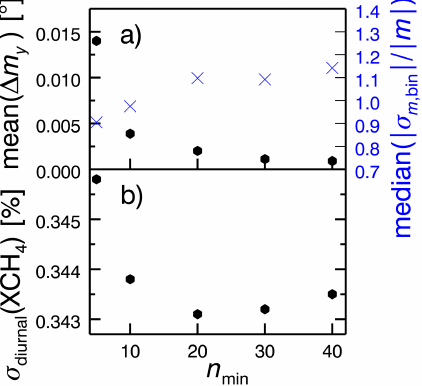
Figure 6. Choice of time bin size for Zugspitze mispointing deter- mination. (a) Mean zenith mispointing error (black) and median of the relative scatter of mispointing results within time bins (blue). (b) Mean 1 σ -XCH 4 diurnal variation.